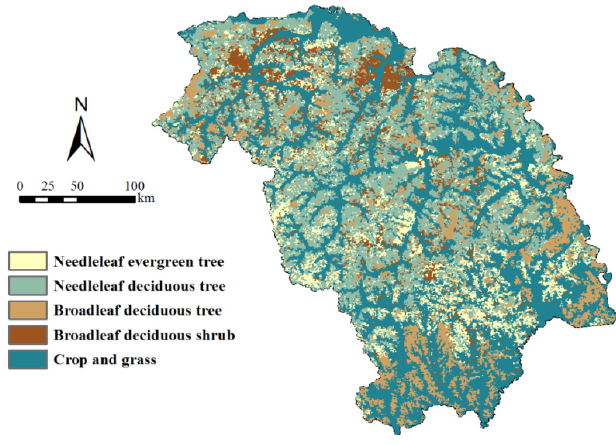
Figure 2. Distribution of forest vegetation types in the study area, Daxing’an Mountains, China.